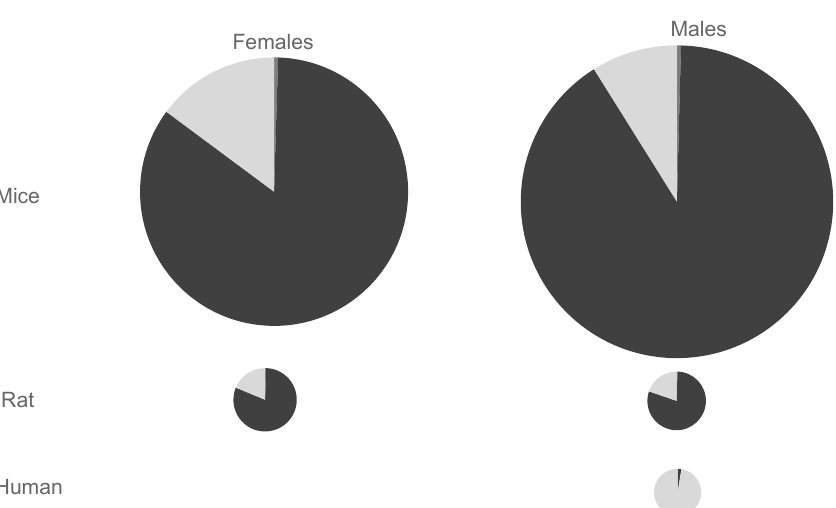
Figure 3. Species differences in the genotoxicity index: pie surface area is proportionate to total cytotoxicity index. Metabolite contributions: DEB = dark shading; EB = medium shading; EBD = light shading.